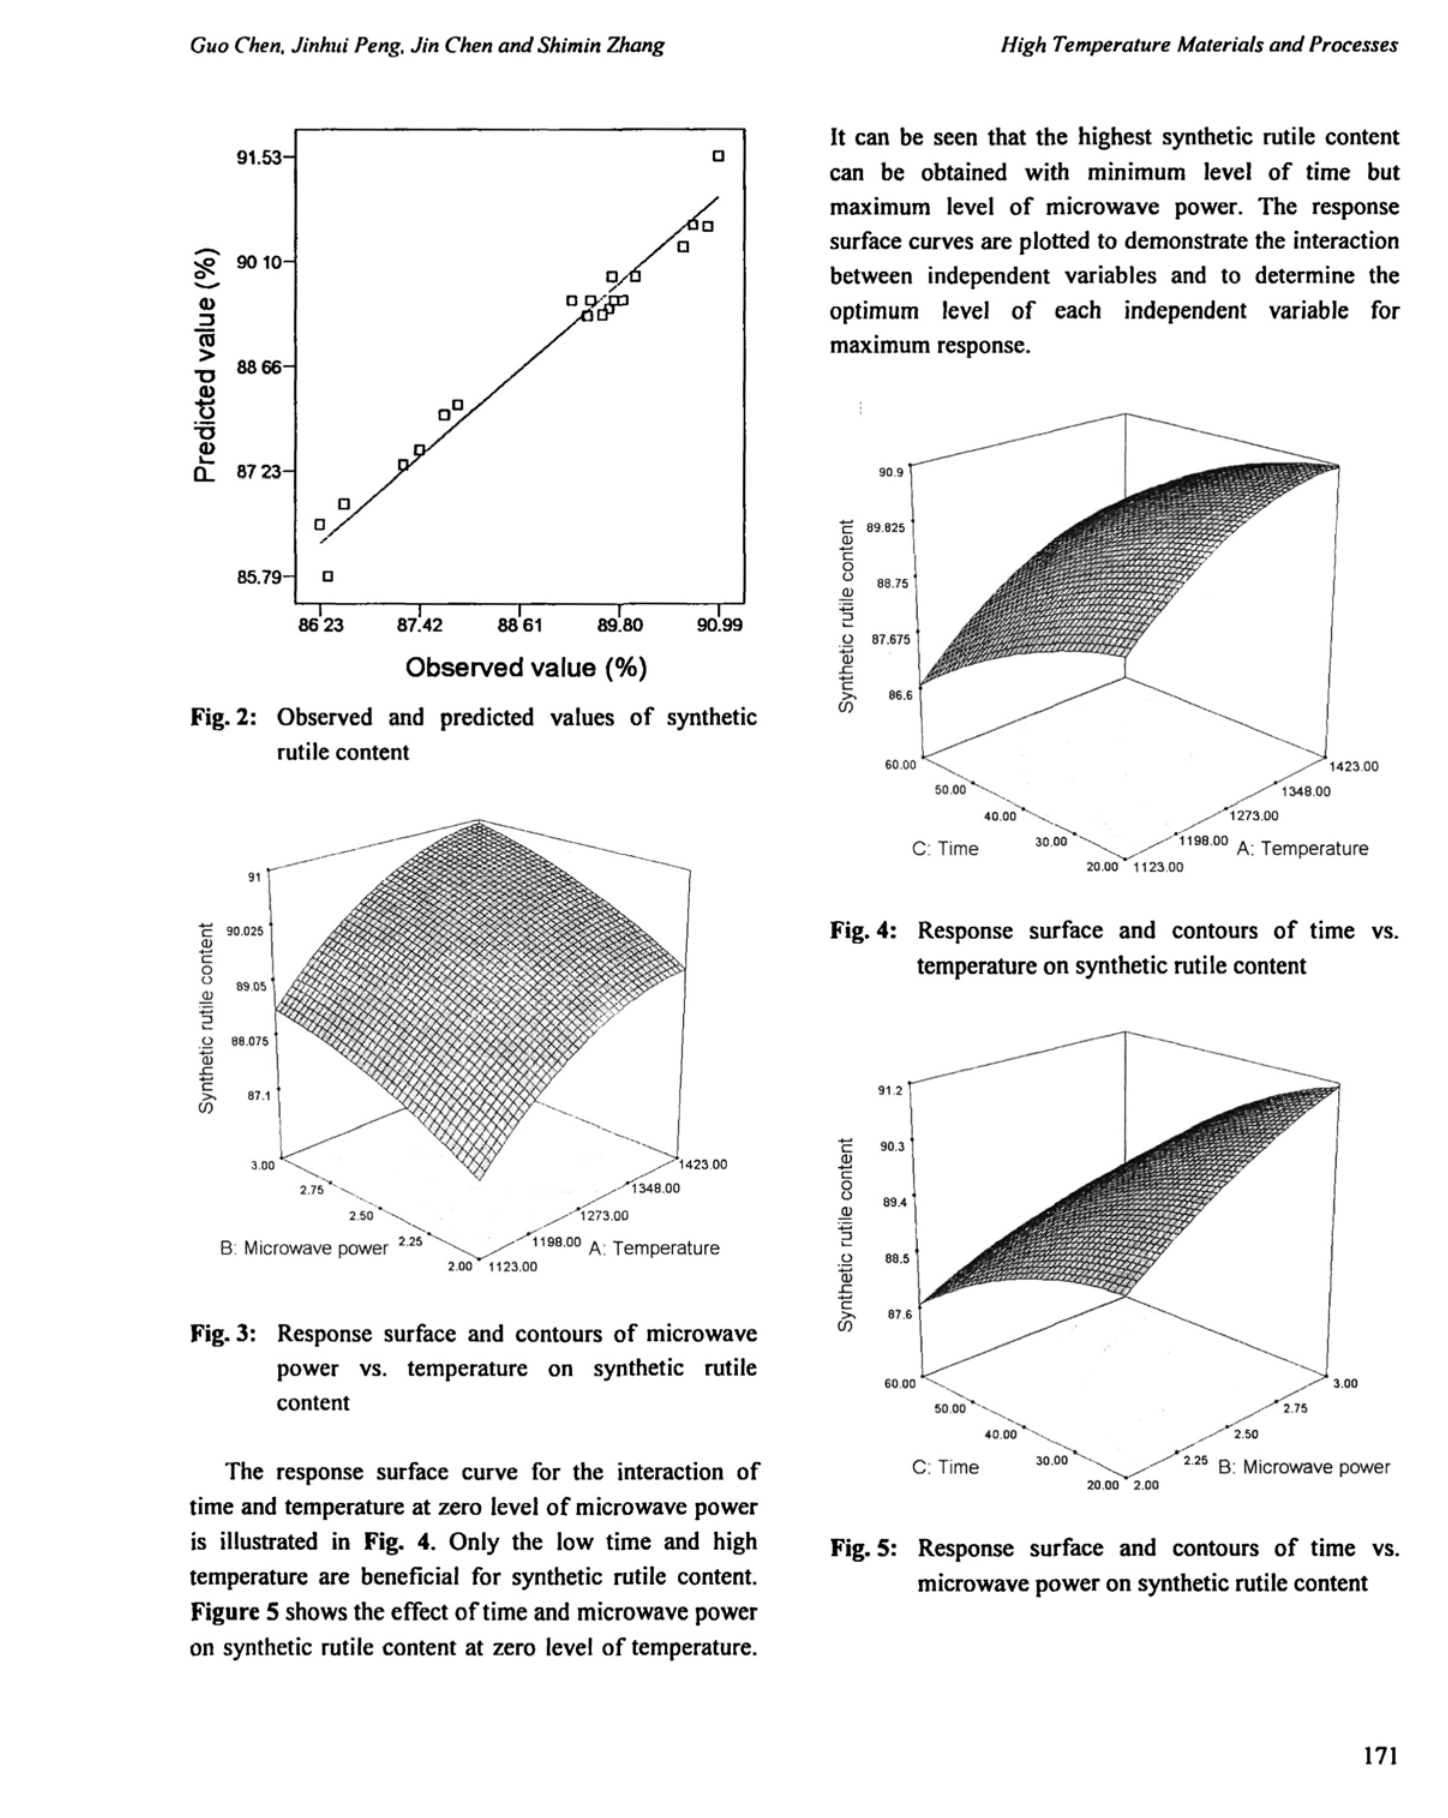
Fig. 5: Response surface and contours of time vs. microwave power on synthetic rutile content